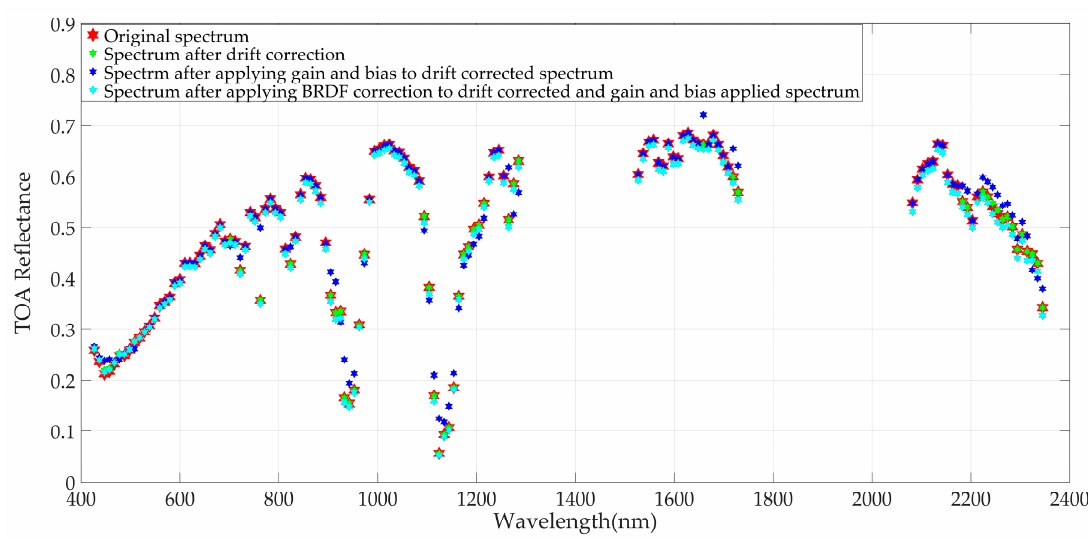
Figure 7. Corrections applied to the hyperspectral profile. Red symbols represent the original spectrum and cyan symbols represent the corrected hyperspectral data. Highly absorption wavelength ranges are not displayed in the figure.